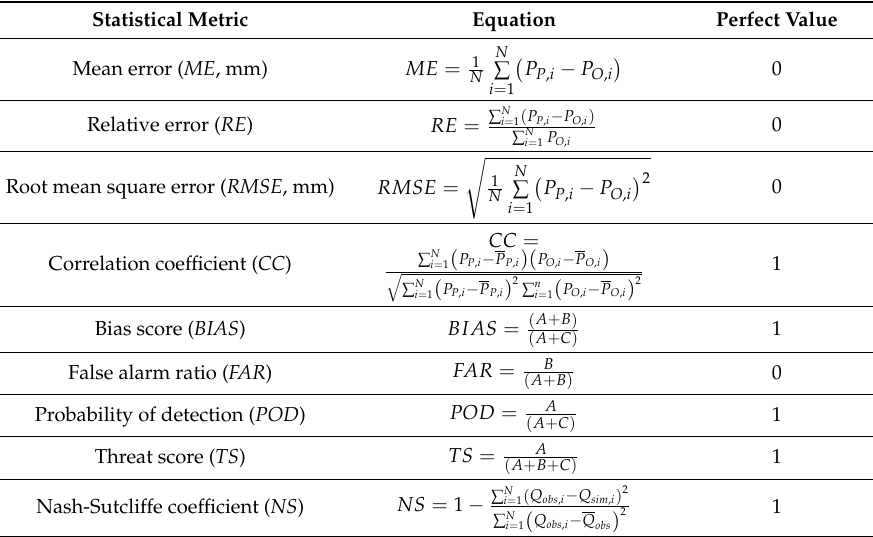
Table 5. Statistical metrics applied in the evaluations